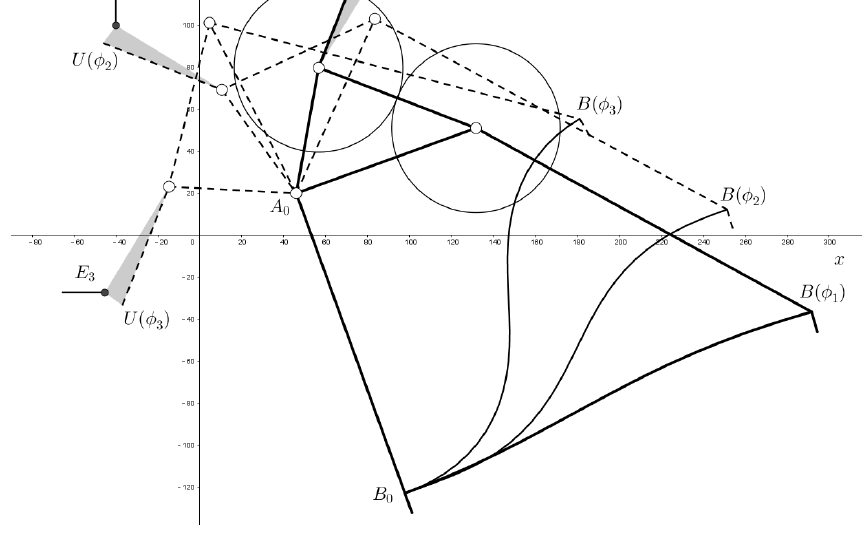
Figure 14. Solution mechanism.